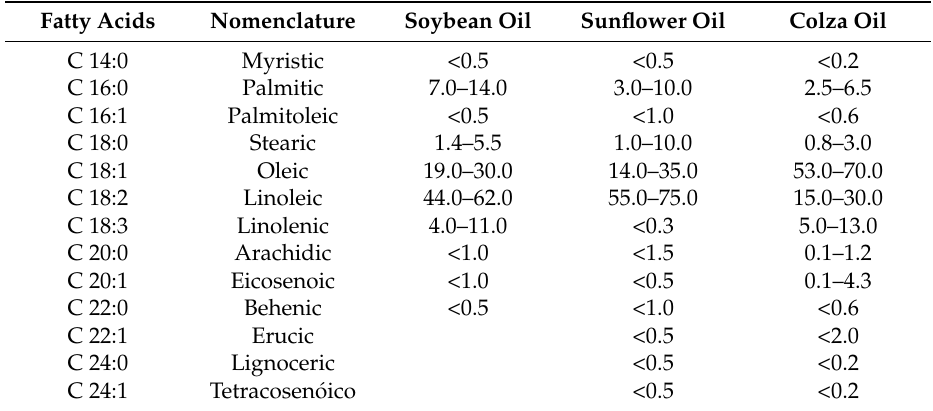
Table 4. Composition of soybean, sunflower and colza oil fatty acids, comparing fatty acids, carbon chain and their